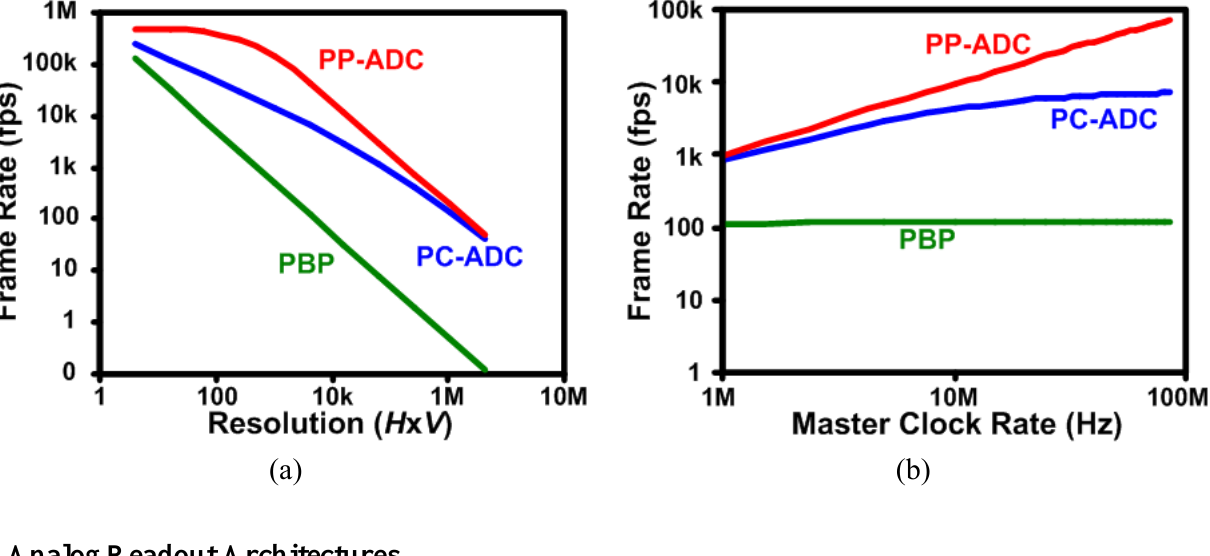
Figure 6. Simulation results of equations (1-3) showing the FR of a pixel-by-pixel, PC- ADC and a PP-ADC readout architectures with 8-bit resolution ADCs ( b =8), four 8-bit parallel outputs ( n =32) and a  = 2  s. (a) The FR as a function of varying the imager ADC resolution with a fixed clock rate of 50 MHz (1/  ). (b) The FR as a function of the clock RO rate with a fixed imager resolution of H  V = 64  64. Both graphs are shown in a log-log